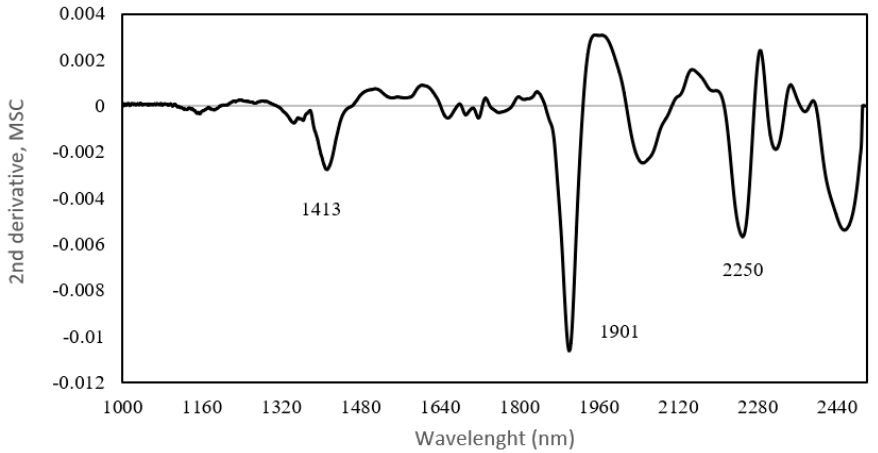
Figure 4. Example of second derivative and multiplicative scatter correction (MSC) of absorbance of extractive content in ethanol–benzene solubility for ebony wood.